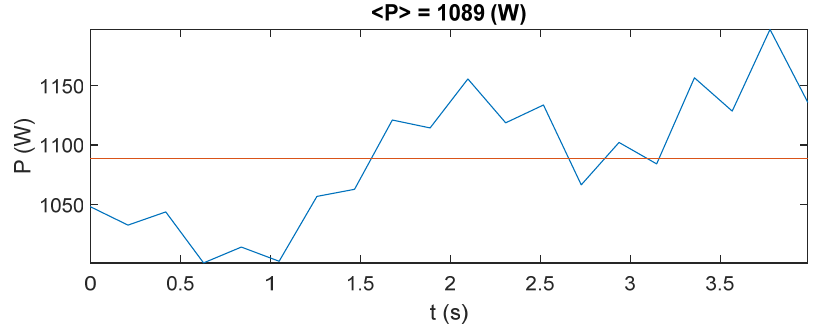
Figure 13. P measurement for the 1-st harmonic.